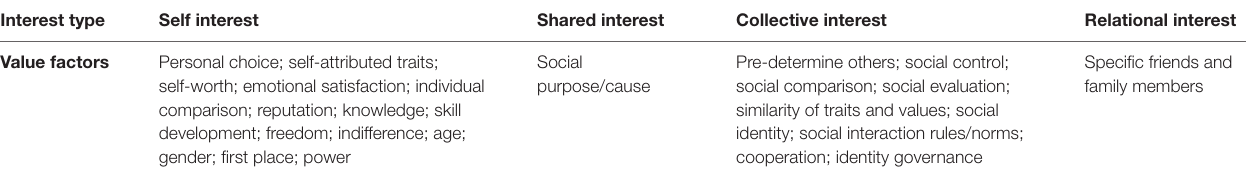
TABLE 1 | Typology of individual and social